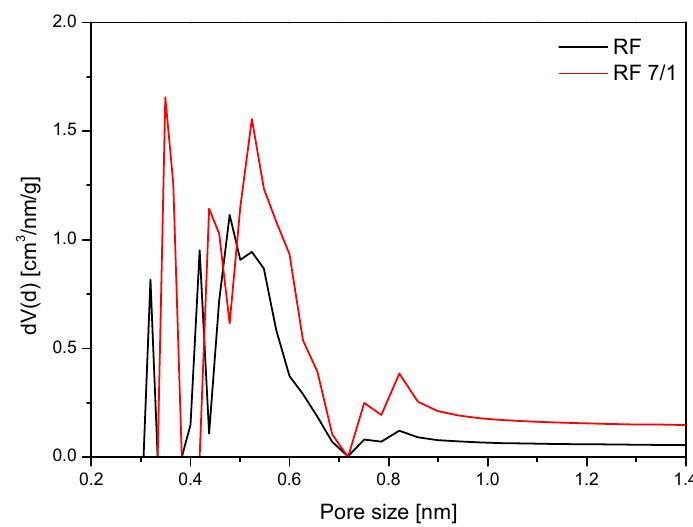
Figure 6. Comparison of the pore size distribution (PSD) of unmodified sample and sample modified with potassium oxalate and without heat treatment.